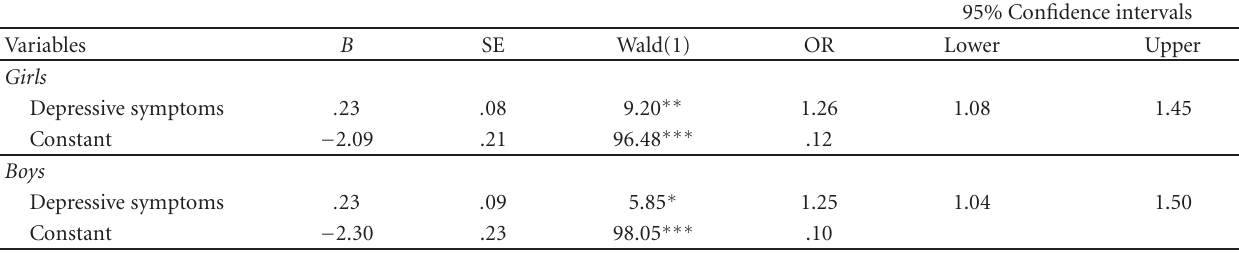
Table 1: Logistic regressions, predicting incidence of repeated self-harm at Time 2 from depressive symptoms at Time 1, among participants with no self-harm at Time 1.